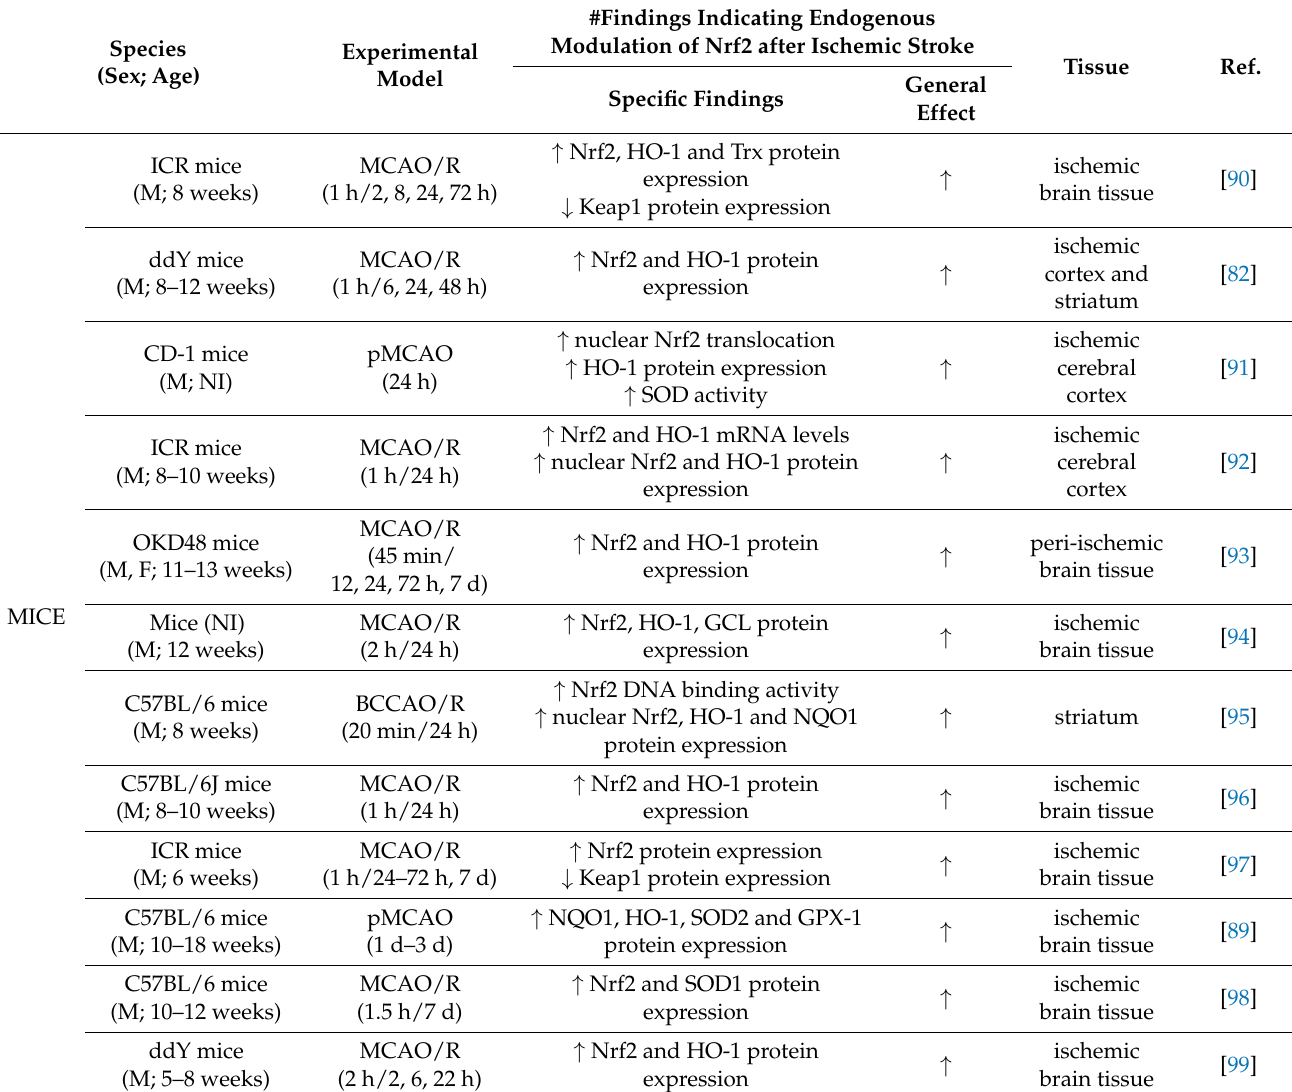
Table 1. In vivo experimental studies reporting the endogenous modulation of Nrf2 and/or Nrf2-downstream proteins after cerebral ischemia or